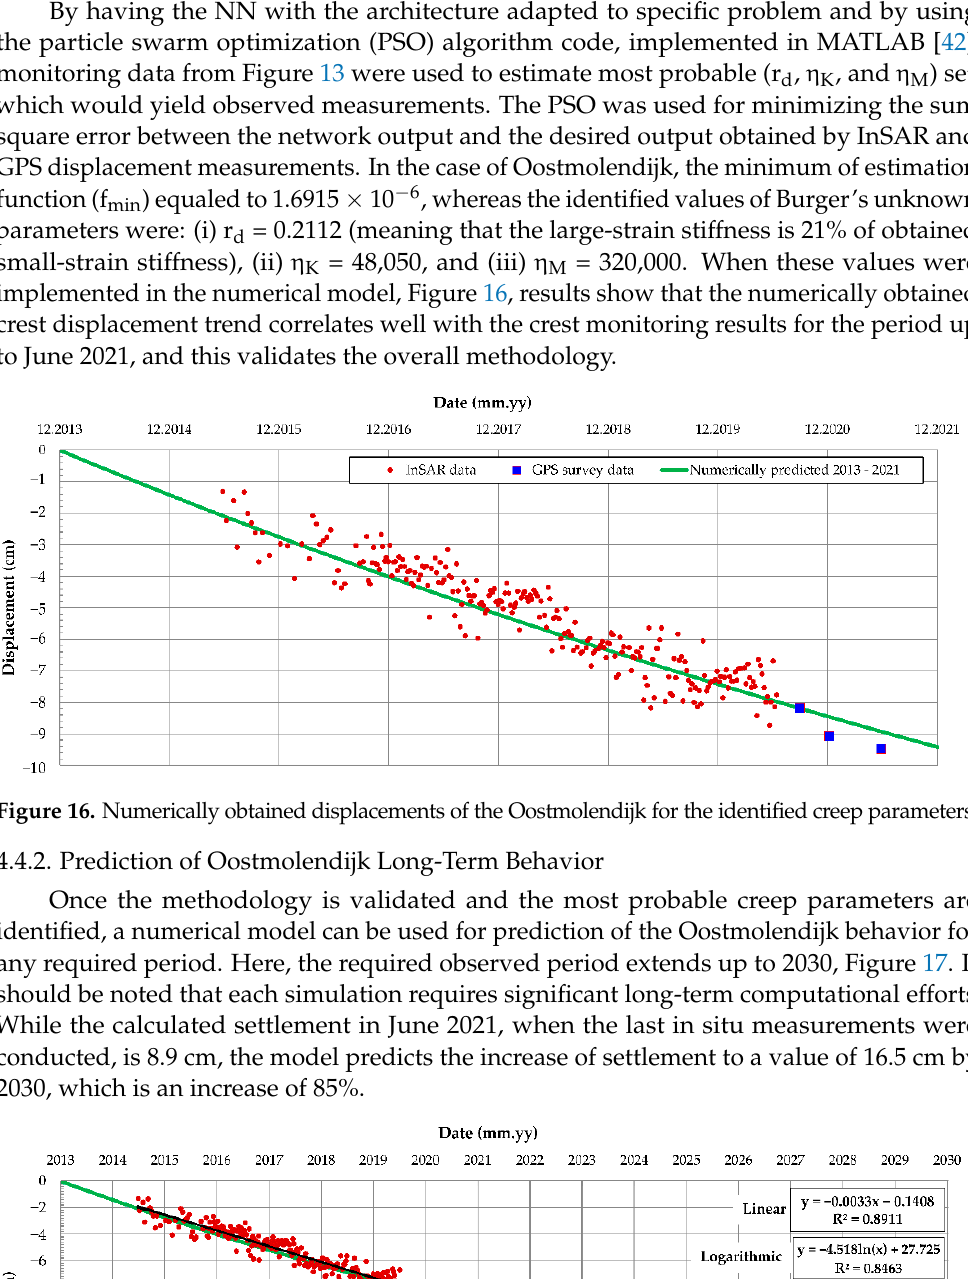
Figure 15. Training ( a ), validation ( b ), testing ( c ), and overall ( d ) datasets with correlation of Net- CREEP predicted time-dependent crest displacements and creep parameters.